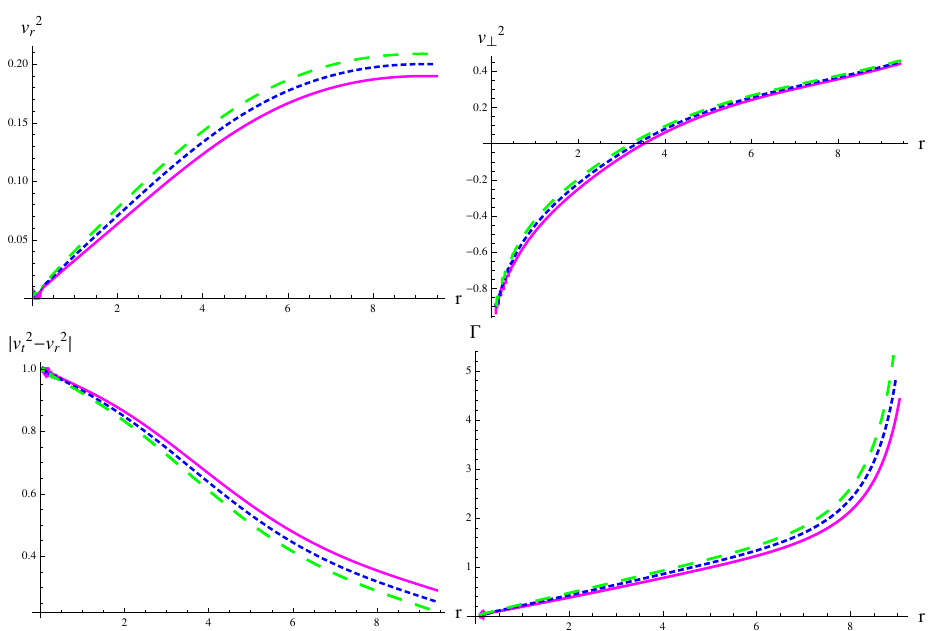
Figure 17. Plots of radial/tangential velocities, | v 2 ⊥ − v 2 r | and adiabatic index of extended solution II for Υ = 0.2.